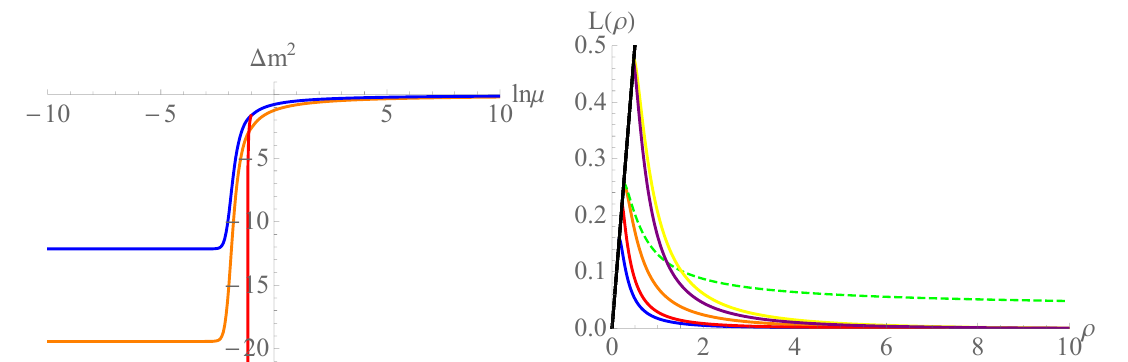
Figure 11. AdS/ Sp(4) 4 F, 6 A 2 . Left panel: the running of ∆ m 2 against RG scale for the fun- damental (blue line), A 2 (orange) and in red the running of the fundamental representation after A 2 have been integrated out. Right panel: the vacuum solution L ( ρ ) : the orange line for the A 2 representation and blue the fundamental without decoupling. The red solution is when we consider the decoupling of the A 2 which condenses before the fundamental. The dashed green line is the fundamental when we consider additional NJL-terms such that it matches in the IR the A 2 repre- sentation. Finally, the yellow and purple vacuum solution correspond to the quenched models for the A 2 and fundamental representations respectively. Here units are set by α ( ρ = 1) = 0 . 65